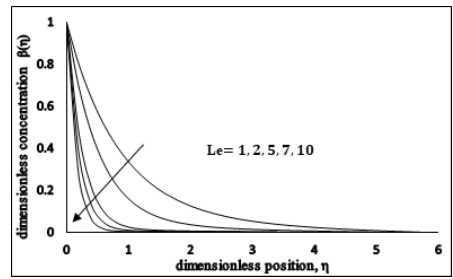
Figure 13. Dimensionless Concentration vs Le